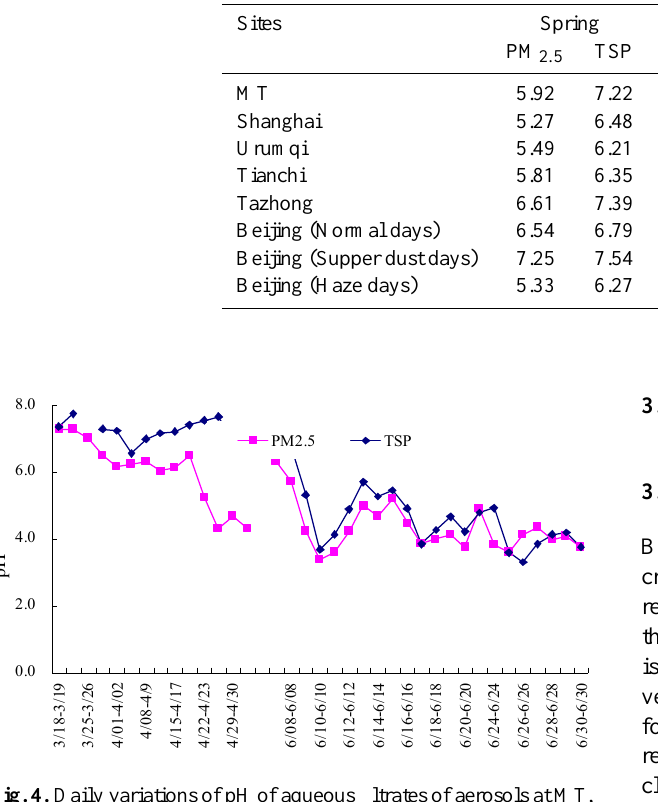
Fig. 5. Daily variations of K + , Na + , and Al in PM 2.5 from 14 March to 30 June in 2006 at MT.